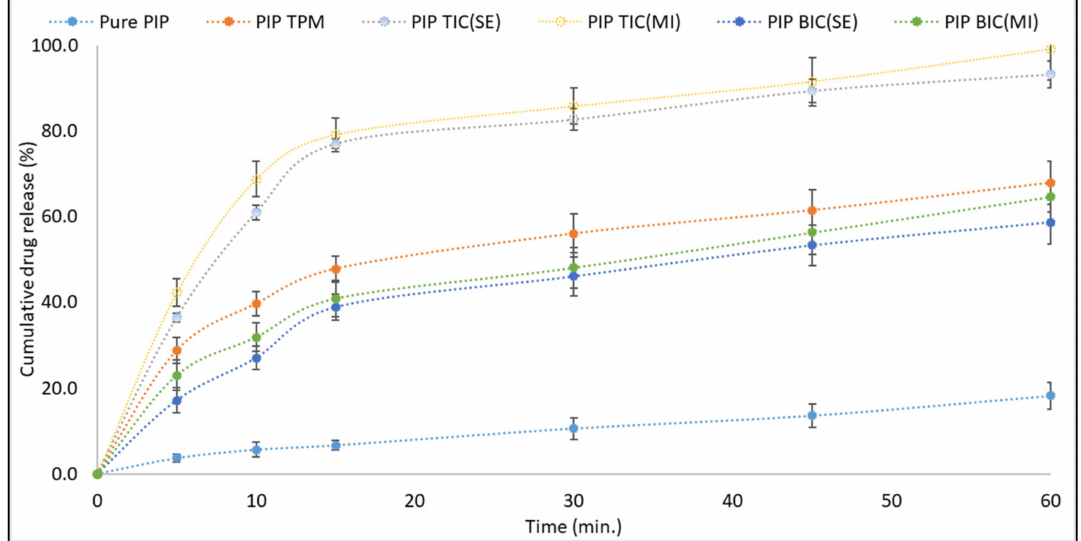
Figure 4. Comparative drug release profile of pure piperine and piperine inclusion complexes (binary and ternary). Values are presented as means ± SD with